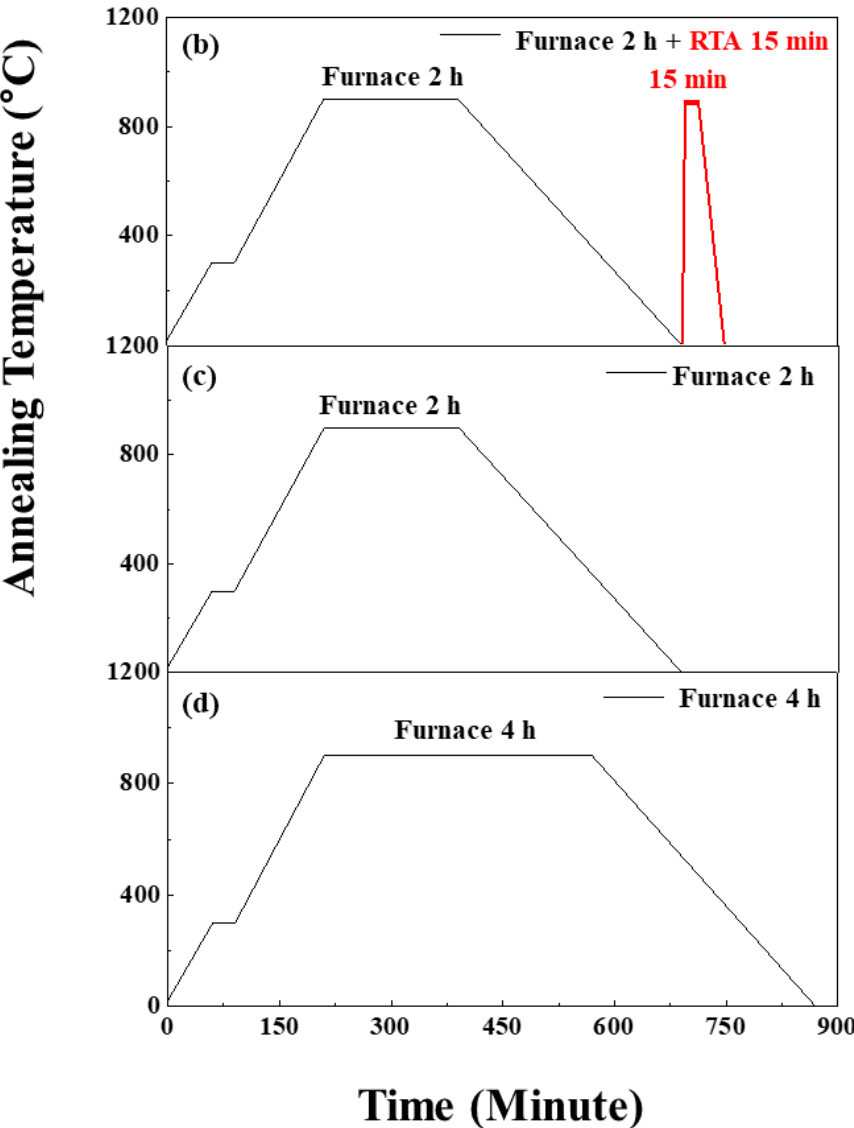
Figure 1. Schematic diagram of β -Ga 2 O 3 thin film annealing method applied with various